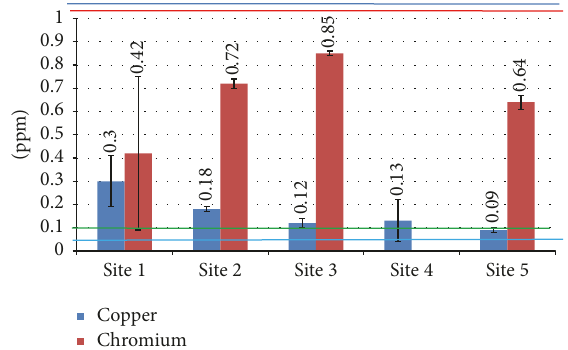
Figure 5: Graphs showing the copper and chromium levels with their respective error bars on standard deviation, observed in the samples of 5 sites of this study, along with the ECR tolerable limit for copper (3ppm) as shown by red line, the ECR tolerable limit for chromium (0.1ppm) as shown by green line, and the NDWQS tolerable limit for chromium (0.05 ppm) as shown by blue line.